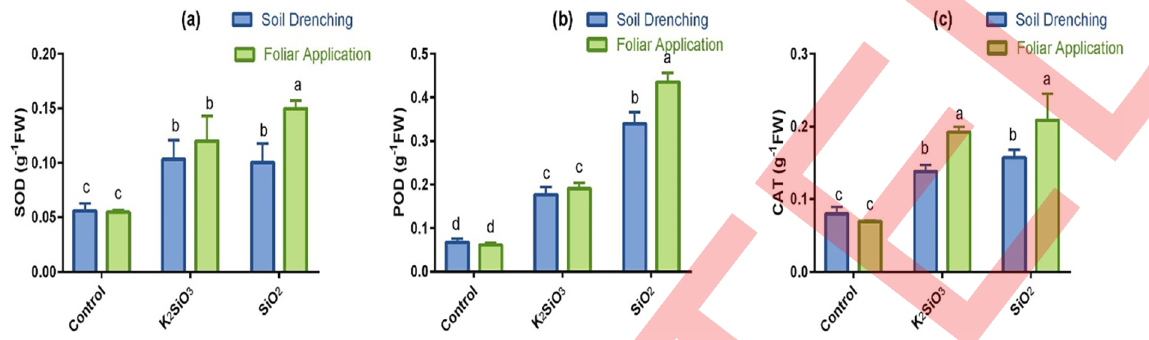
Fig 6. Effect of Si sources and Si application methods on antioxidant enzymes activity of maize. Bars with different lower-case letters are significantly different; LSD test at p � 0.05. Vertical bars indicate SD.